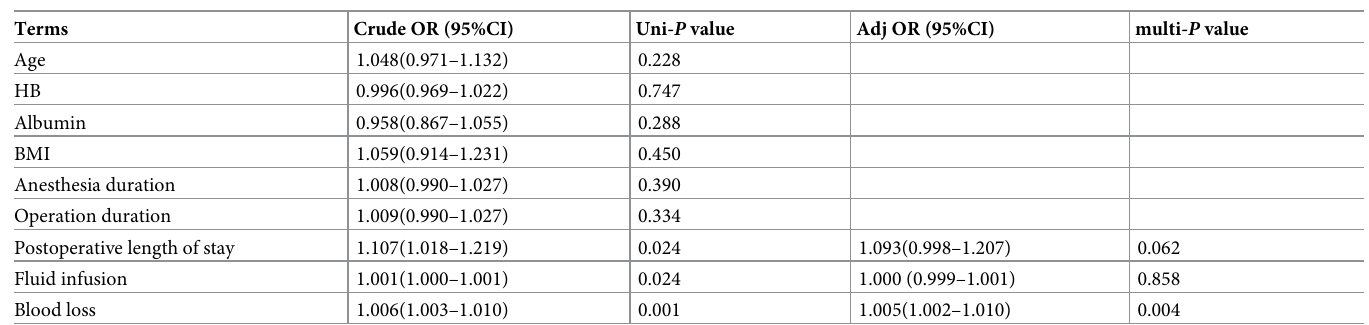
Table 3. Association between delirium and